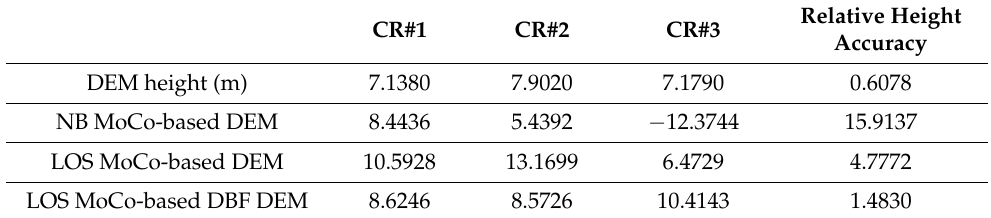
Table 7. DEM height evaluation of corner